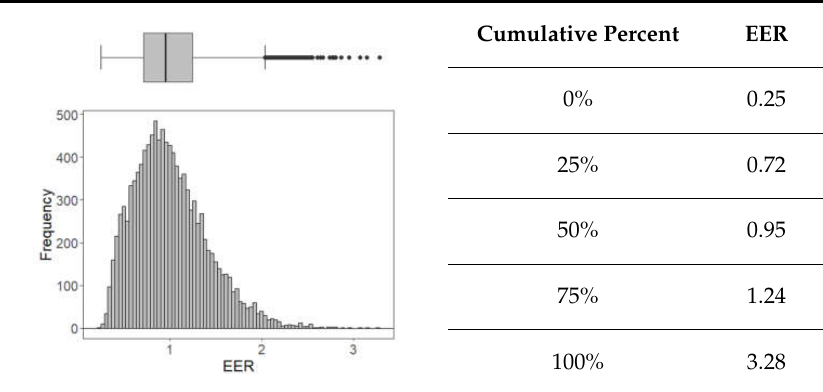
Table 10. Energy performance evaluation result of office building.